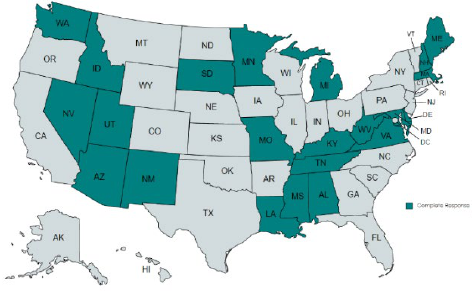
Figure 1 . Complete responses from state DOTs.